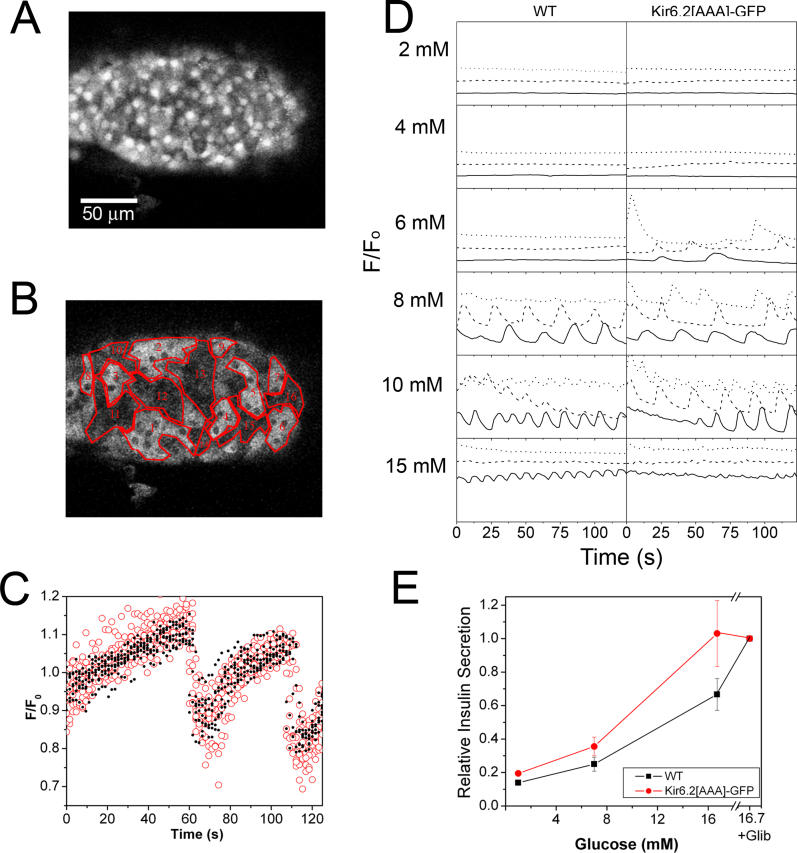
Whole-Islet Cai and Insulin Responses(A) Fluorescence (488-nm excitation and 620–680-nm emission band-pass filter) image of a Fura Red–labeled Kir6.2[AAA] islet. As with labeling of intact WT islets, the fluorescence intensity of Kir6.2[AAA] islets shows increased intensity in the nucleus and relatively little intensity variance across the tissue.(B) Fluorescence (488-nm excitation and a 540/20-nm band-pass filter) image of the same islet. Note that in (A) the islet is uniformly labeled and there is no indication of GFP fluorescence bleed-through. In (B), 16 regions that were either positive (eight regions) or negative (eight regions) for Kir6.2[AAA]-GFP transgene expression, are outlined in red.(C) The Cai responses in 6 mM glucose from groups of cells (outlined in [B]) that are either Kir6.2[AAA]-positive (filled black circle) or -negative (open red circle) demonstrated identical oscillatory behaviors, indicating that both are in synchrony.(D) A comparison of glucose-stimulated Cai responses measured using Fluo-4 from WT (left) and Kir6.2[AAA] (right) transgenic islets. Islets were exposed to the indicated glucose concentrations for greater than 10 min by changing the reagent well solution. Images were then collected at 1.5-s intervals over a period of 125 s. In contrast to the traces found in (C), each trace in each panel (solid, dot, and dashed) represents a whole single islet. These islet traces are done to show the dose -response of individual islets rather than synchrony across the tissue. WT islets showed no oscillatory behavior until treated to 8 mM glucose or greater (responses of three different islets are shown). Kir6.2[AAA] islets were also quiescent at low glucose concentrations; however, these islets showed Cai oscillations at 6 mM glucose or above (n = 5 islets).(E) Glucose-stimulated insulin secretion from WT and Kir6.2[AAA] islets (mean ± SEM, n = 17 and 15, respectively). Islets were also exposed to 16.7 mM glucose + glibenclamide (Glib) to achieve maximum possible insulin secretion. The difference in means ± 95% confidence interval is shown in Figure S2A.